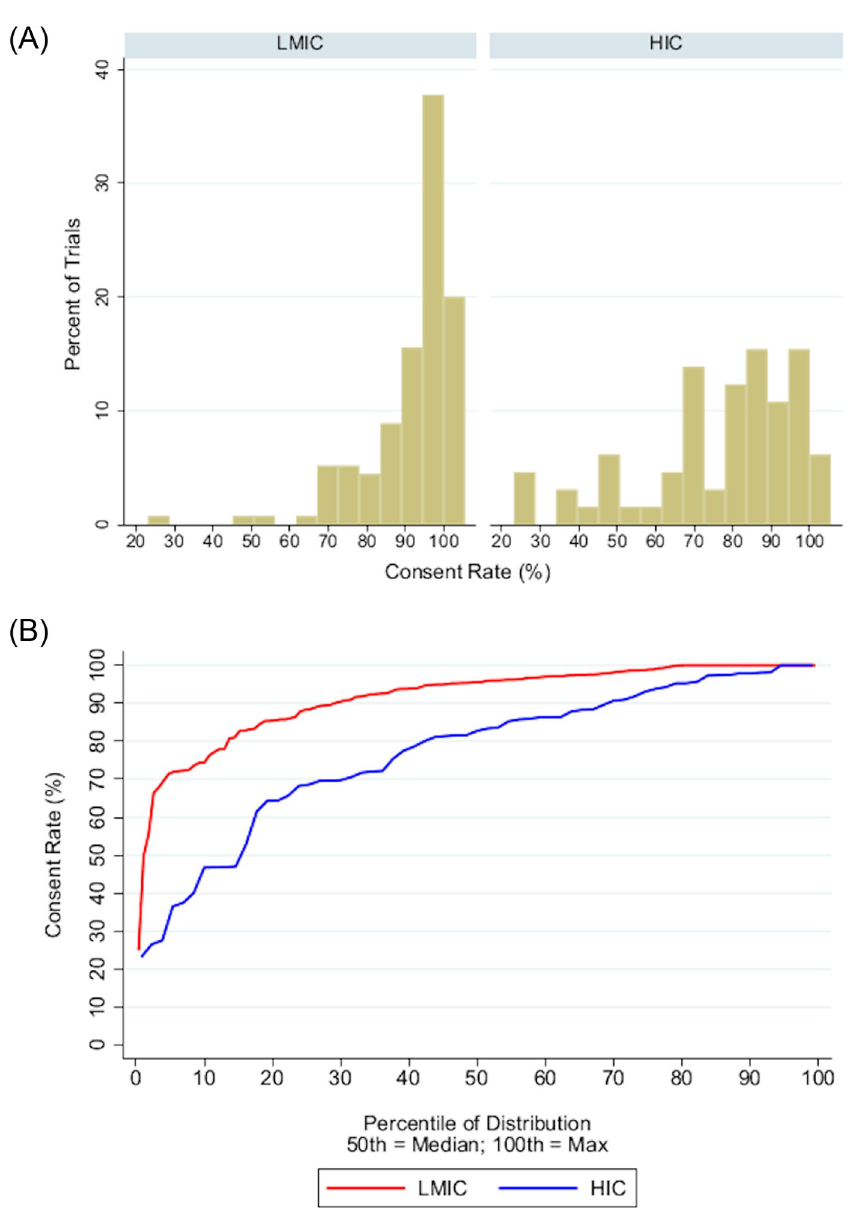
Fig 3. Distribution of LMIC versus HIC trials by consent rate. Part A: The histogram depicts the percent of LMIC versus HIC trials per consent rate increments of five percent. LMIC trials are left-skewed towards high consent rates. Part B: The cumulative density function depicts the percent of trials that have a consent rate equal to or less than y. Across the entire distribution, LMIC consent rates were consistently higher than HIC consent rates (p < 0.0001; Two- Sample Wilcoxon Rank-Sum Test). 5% of LMIC trials had a consent rate less than 70% compared to one third of HIC